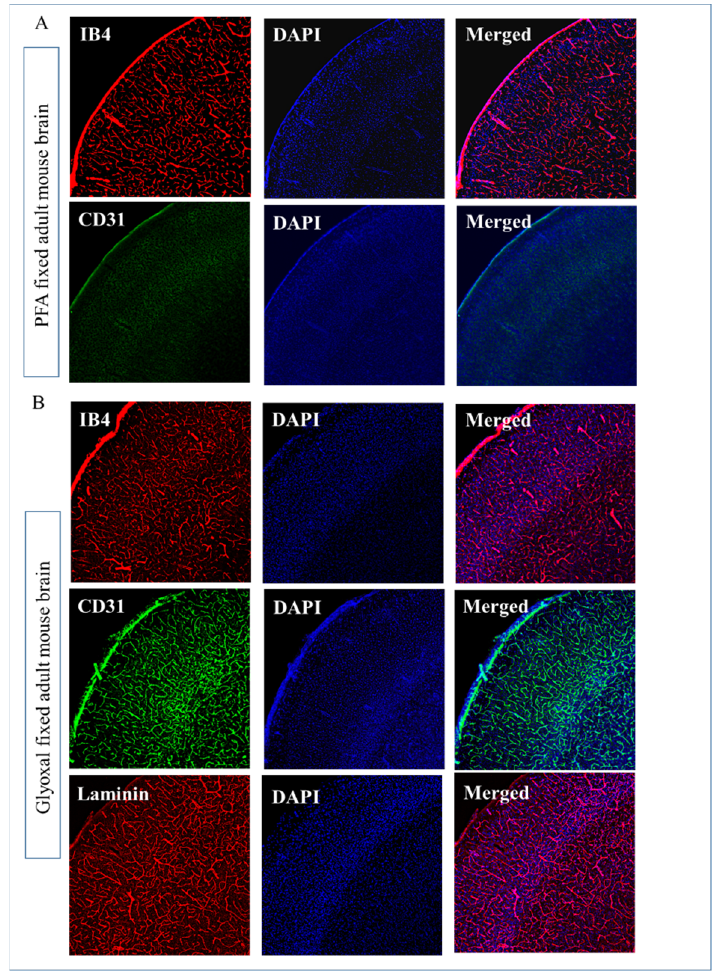
Figure 2. Immunostaining of commonly used antibodies in vascular staining comparison between 4% PFA and 3% glyoxal fixation. ( A ) 35 microns coronal plane slices of PFA fixed brain after IB4 (red) and CD 31(green) staining and nuclei were detected by DAPI nuclear stain. ( B ) The coronal plane slices of glyoxal fixed brain after IB4(red), CD 31 (green), and laminin staining (red), nuclei were detected by DAPI nuclear stain.